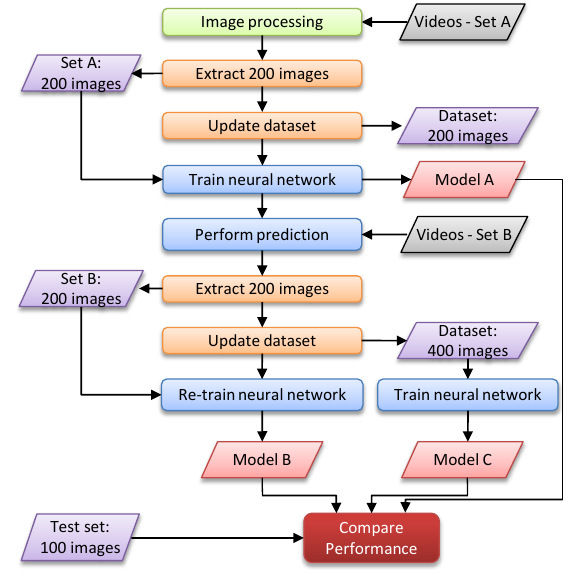
Figure 5: Flow diagram of the experiment’s